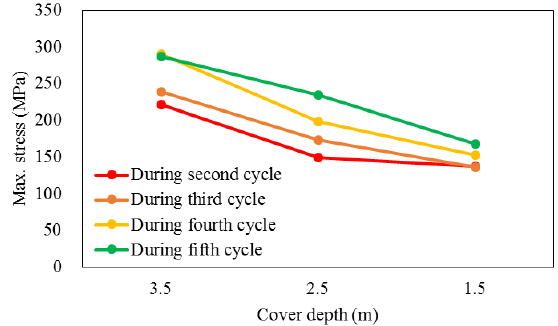
Figure 19. Maximum stresses acting on piles during Stage 1 of each construction cycle based on cover depth.